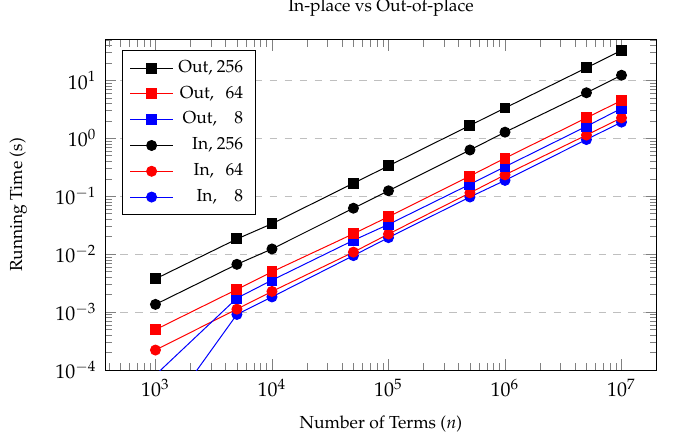
Figure 4. Comparing in-place and out-of-place polynomial addition. Random rational number polynomials in 3 variables are added together for various numbers of terms and for various coefficient sizes. The number of bits needed to encode the coefficients of the operands are shown in the legend. Notice this is a log-log